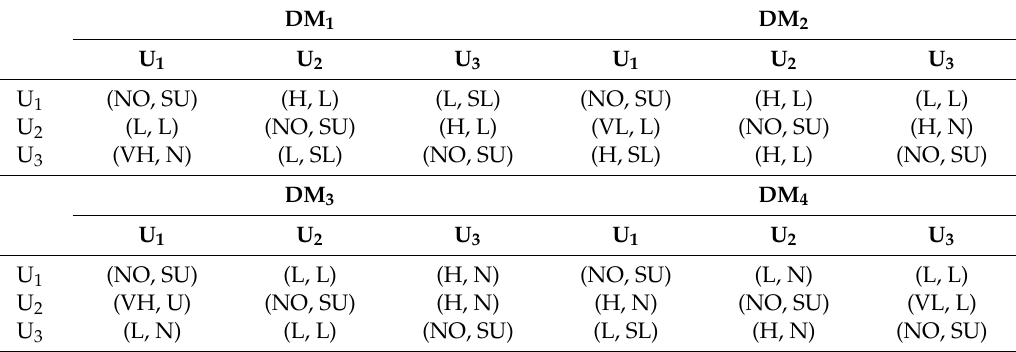
Table 12. The Z -number linguistic variables direct influence matrix.